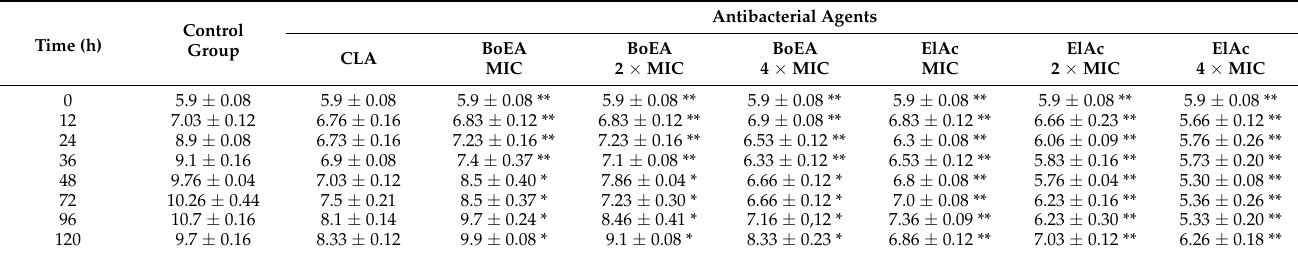
Table 9. Time–kill evaluation of Mabs with BoEA and ElAc. Clarithromycin concentration was used at MIC. Growth control: no compound was added to the cell suspension.